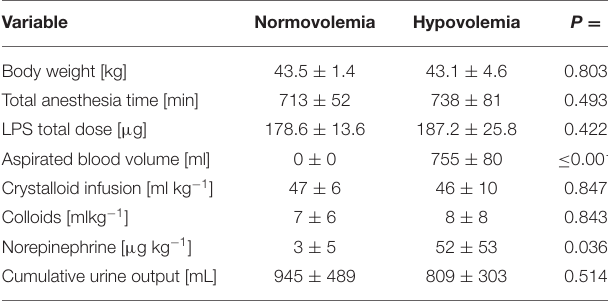
TABLE 1 | Characteristics of the animal and experimental